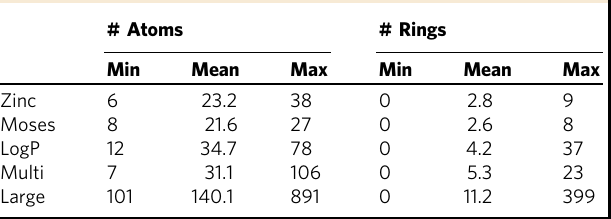
Fig. 1a with most training molecules resembling the examples